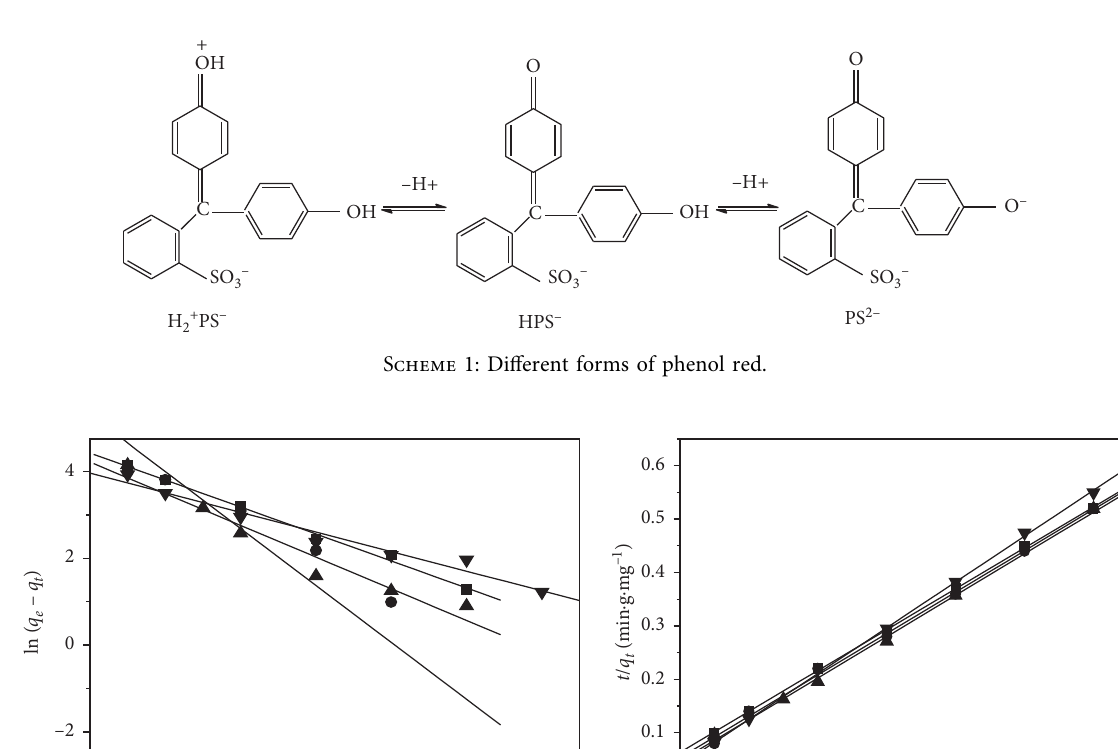
Figure 7: Effect of pH on the adsorption uptake of phenol red onto CB, AlCB, and FeCB samples ( C K m � 0.05 g t � 6 h).